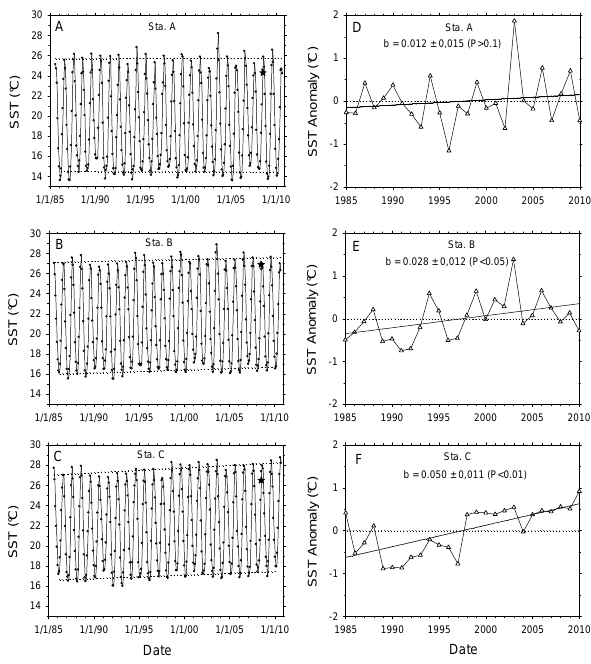
Fig. 3. Time plots over the 1985–2010 period of sea surface tem- perature (SST) as measured by satellite (A, B, C) and average SST anomaly for the three summer months (D, E, F) in the 1 ◦ latitude- longitude grid around the long term stations of the BOUM cruise (Sta. A, B and C; data: NOAA). The 25-year trend for the coldest (March) and warmest (August) months (dotted lines) and the actual SST measured on board during the BOUM cruise (stars) are indi- cated on plots A–C . The trend curve (plain line) and corresponding slope (b) and P-values are shown on plots E–F .